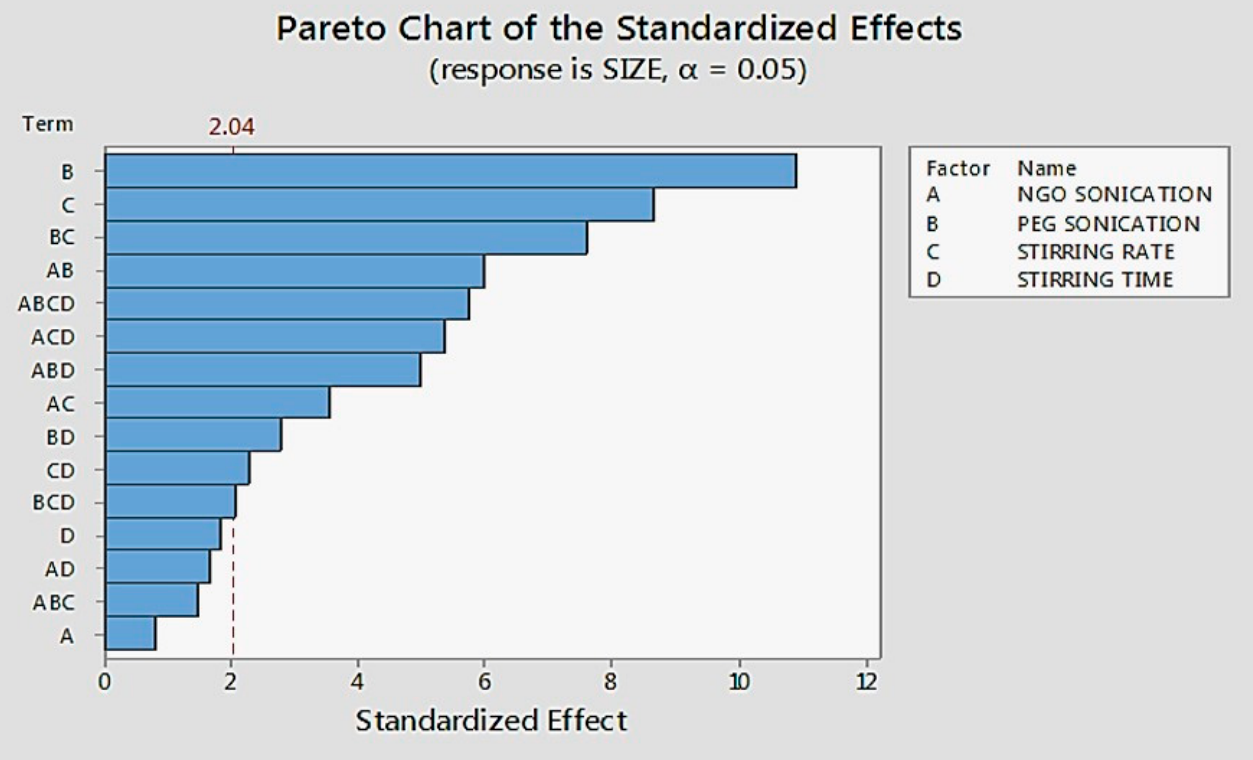
Figure 2. Pareto plot showing the impact of process parameters on the average particle size of the AMP loaded NGO-PEG suspension.